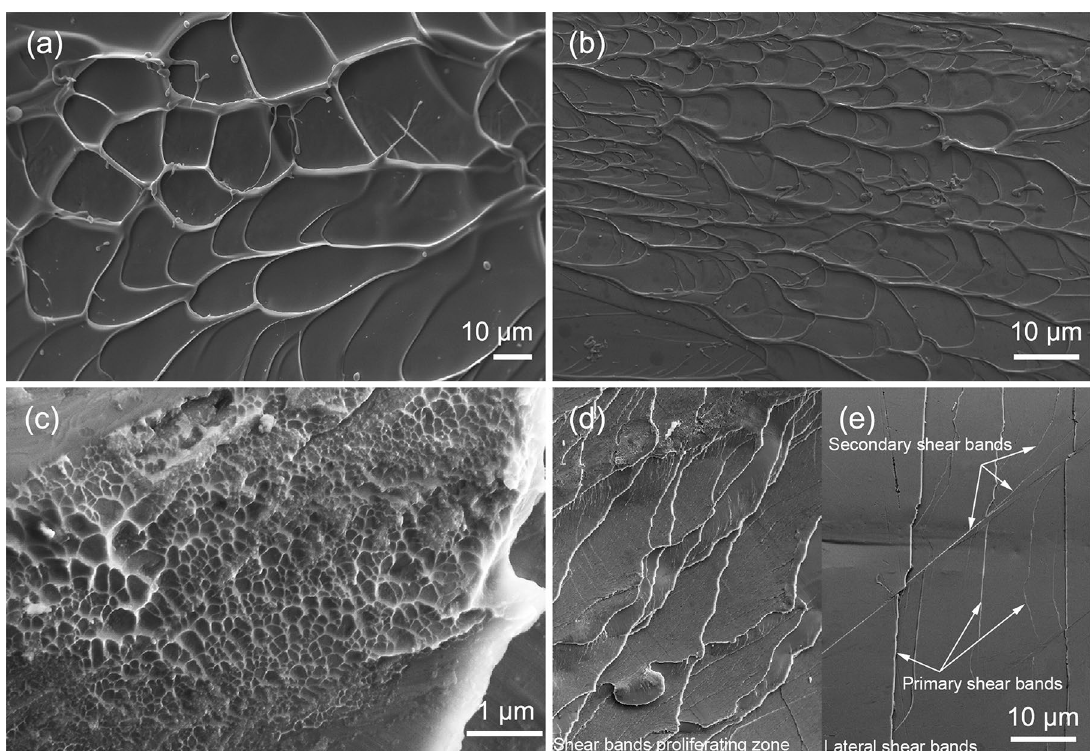
Figure 8. The fracture surface SEM images of the samples annealed at lower temperatures: (a), (b) vein patterns at 680 K, 700 K; (c), (d), (e) nanoscale vein patterns, frontal shear bands and lateral shear bands at 720